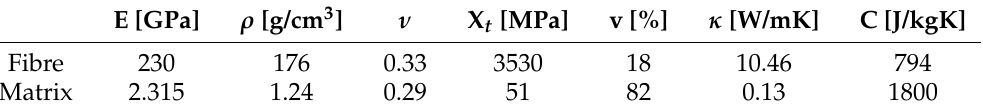
Table 3. Specimen parameters.